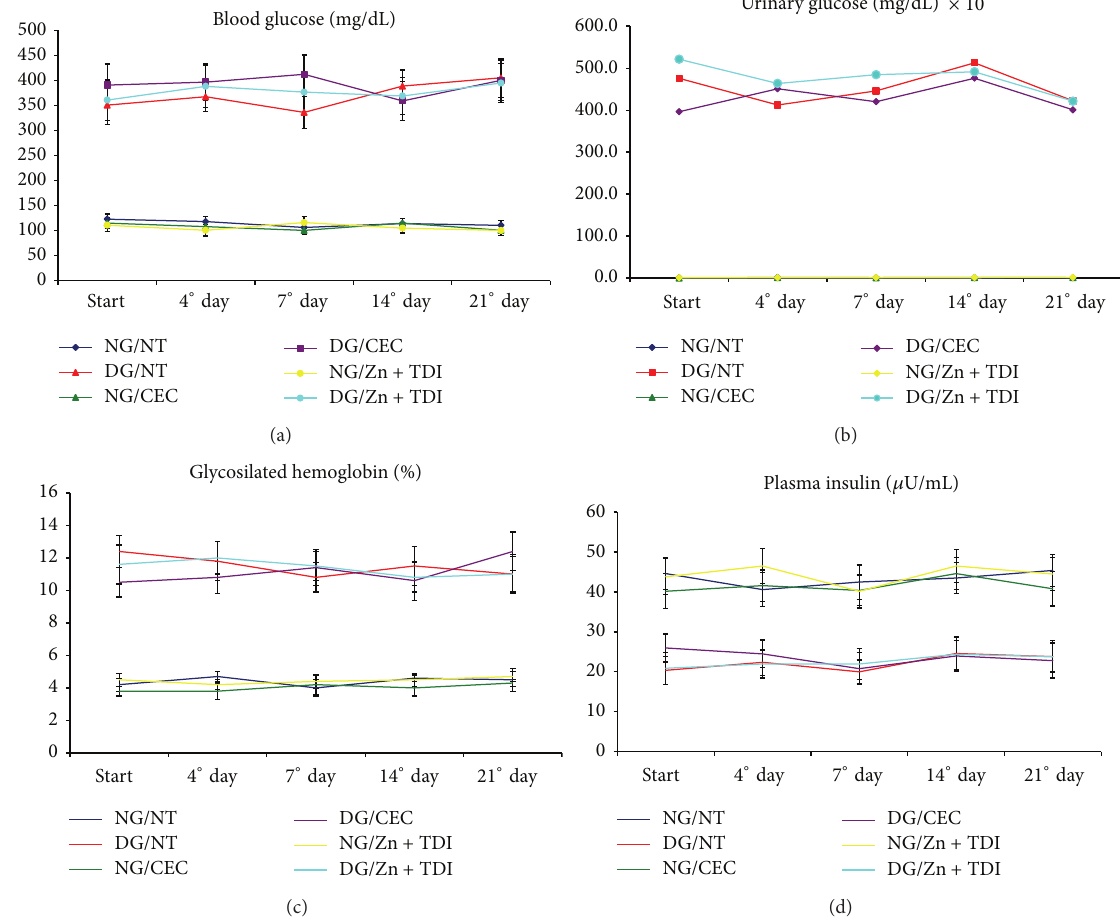
Figure 3: Graphs showing the variation of laboratory parameters in six experimental groups during follow-up: (a) blood glucose (mg/dL); (b) urinary glucose (mg/dL); (c) glycosylated hemoglobin (%); (d) plasma insulin ( 𝜇